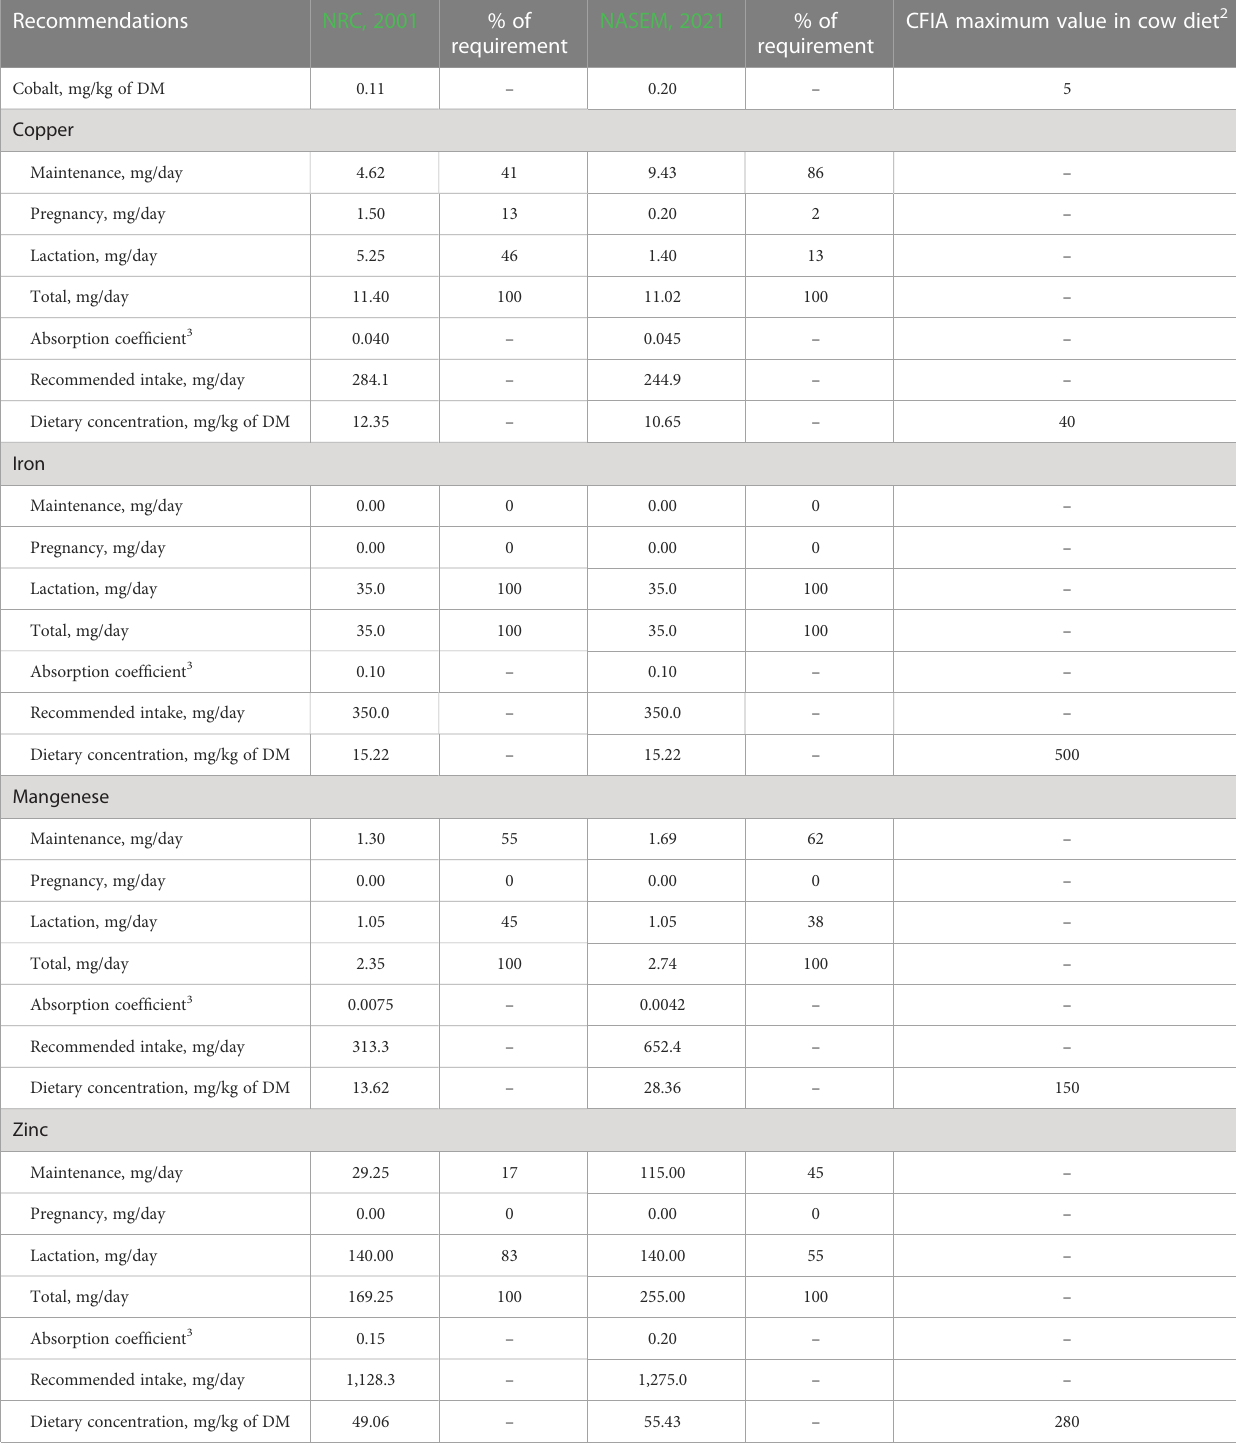
TABLE 1 Comparison between previous dietary recommendations of cobalt, copper, iron, manganese, and zinc in dairy cows from National Research Council and current from National Academies of Sciences, Engineering, and Medicine 1